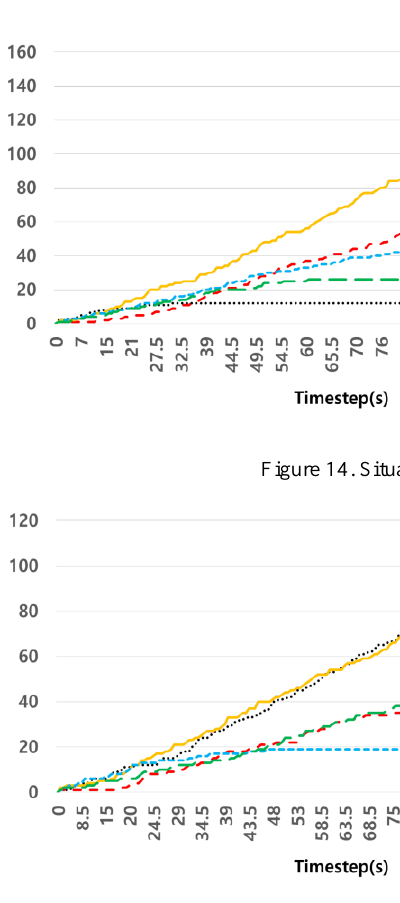
Figure 15. Situation 3: Evacuation when a fire initiated at location